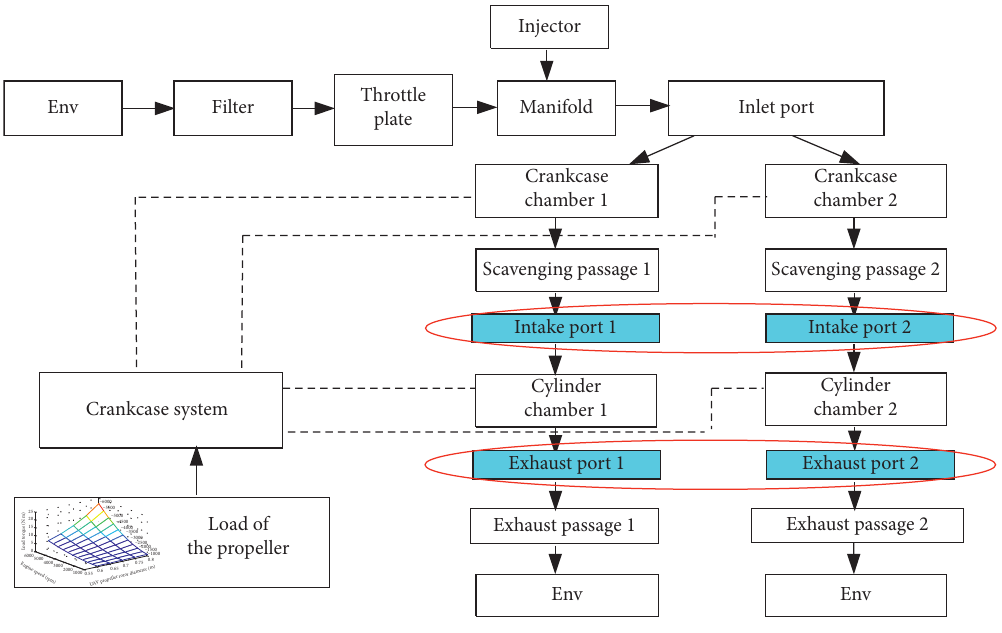
Figure 3: Working process of the two-stroke aeroengine.